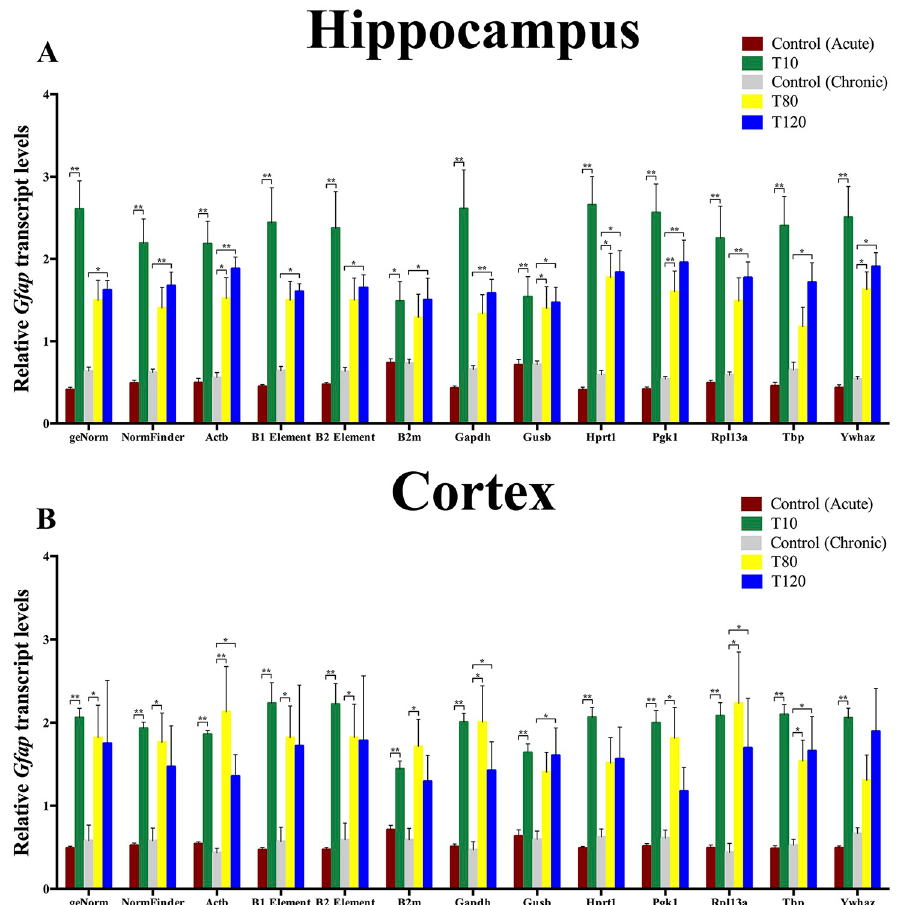
Fig 5. Transcription profiles of Gfap in two brain regions upon using different normalization approaches. (A) The relative expression of Gfap in the hippocampus, normalized using each of the nine reference genes, the B elements or the best combination derived from the NormFinder and geNorm analysis. (B) The relative expression of Gfap in the cortex normalized by nine reference genes, B elements or the best combination derived from the NormFinder and geNorm analysis. The graphs show the mean Gfap expression during the acute (acute phase control vs. T10) and chronic (chronic phase control vs. T80/T120) phase, Mann-Whitney U Test or Kruskal-Wallis Test respectively, � = P � 0.05, �� = P �